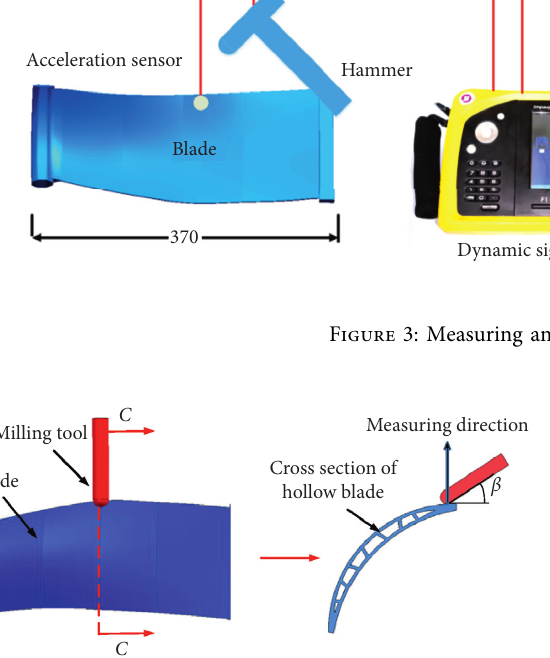
Figure 4: Schematic diagram of measuring directions.